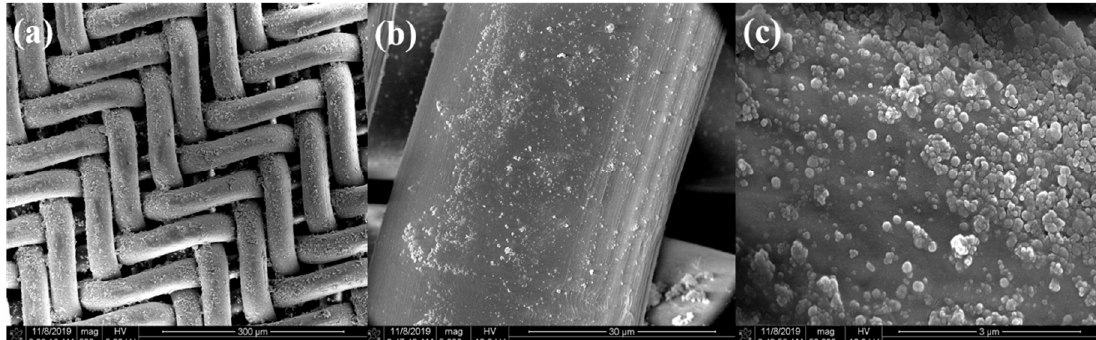
Figure 7. SEM images of the methylated silica coating on a PP filter cloth. ( a ) PP filter cloth coated with methylated silica. ( b ) A single thread of PP filter coated with methylated silica. ( c ) The methylated silica coating on surface of the PP filter.